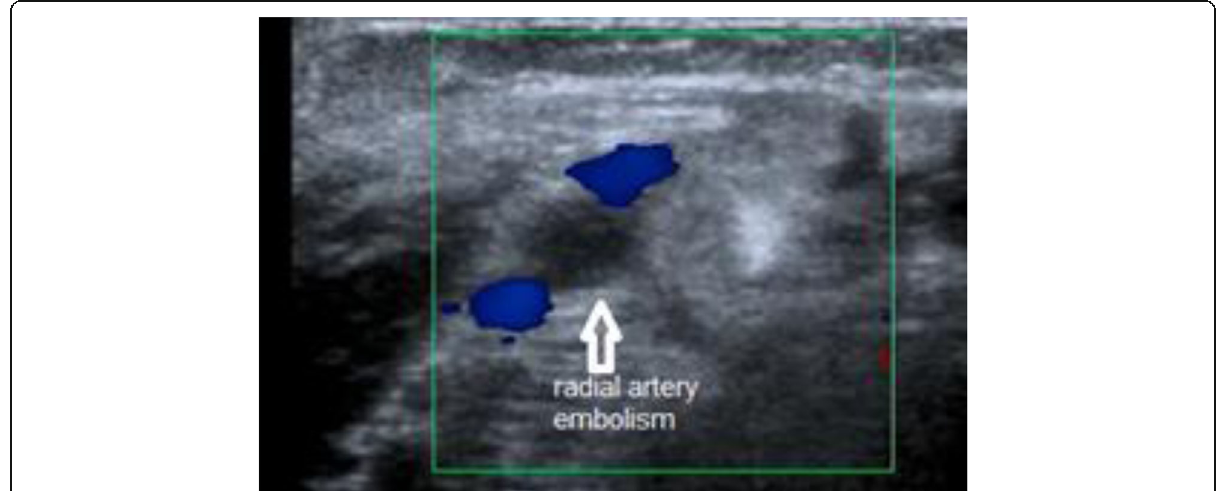
Fig. 7 Color image of the occluded distal radial artery (open white arrow) by embolism from proximal long-standing VTOS; note the blue-coded radial vena comitants denoting their patency